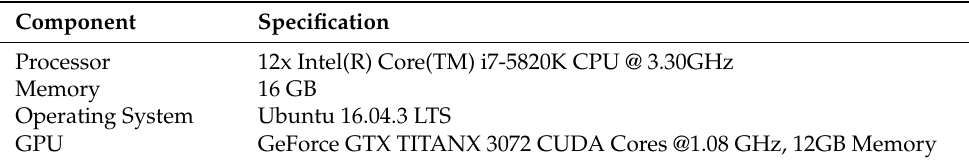
Table 2. Specification for the computer where the experiments were